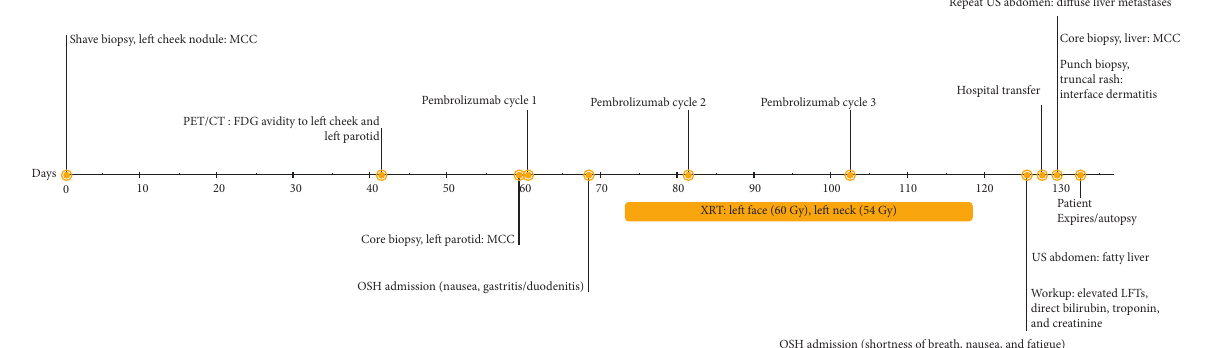
Figure 1: Patient clinical course. A timeline was provided beginning at day 0, set to the initial histological Merkel cell carcinoma diagnosis of the left cheek nodule. Abbreviations: MCC, Merkel cell carcinoma; PET/CT: positron emission tomography/computed tomography; FDG: fluorodeoxyglucose; OSH: outside hospital; XRT: radiation therapy; US: ultrasound; LFTs: liver function tests.